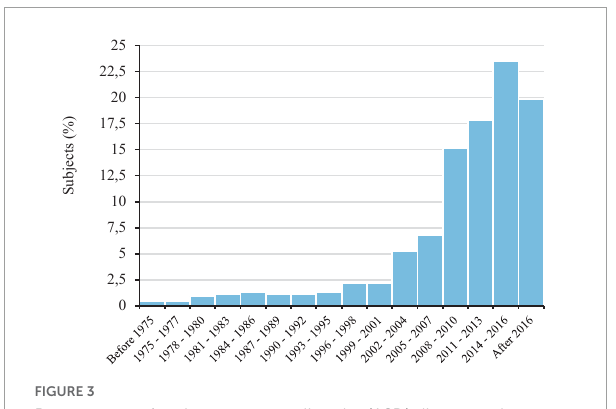
FIGURE3 Percentages of autism spectrum disorder (ASD) diagnoses between before 1975 and after 2016.